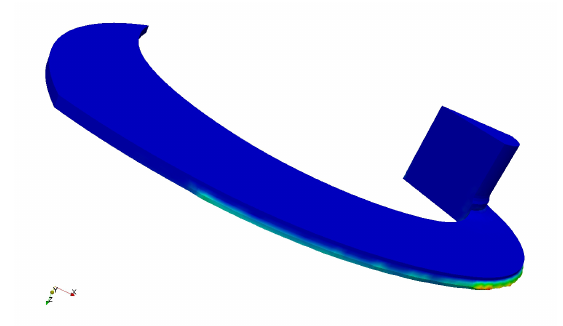
Figure 8: Deformed pump channel according to